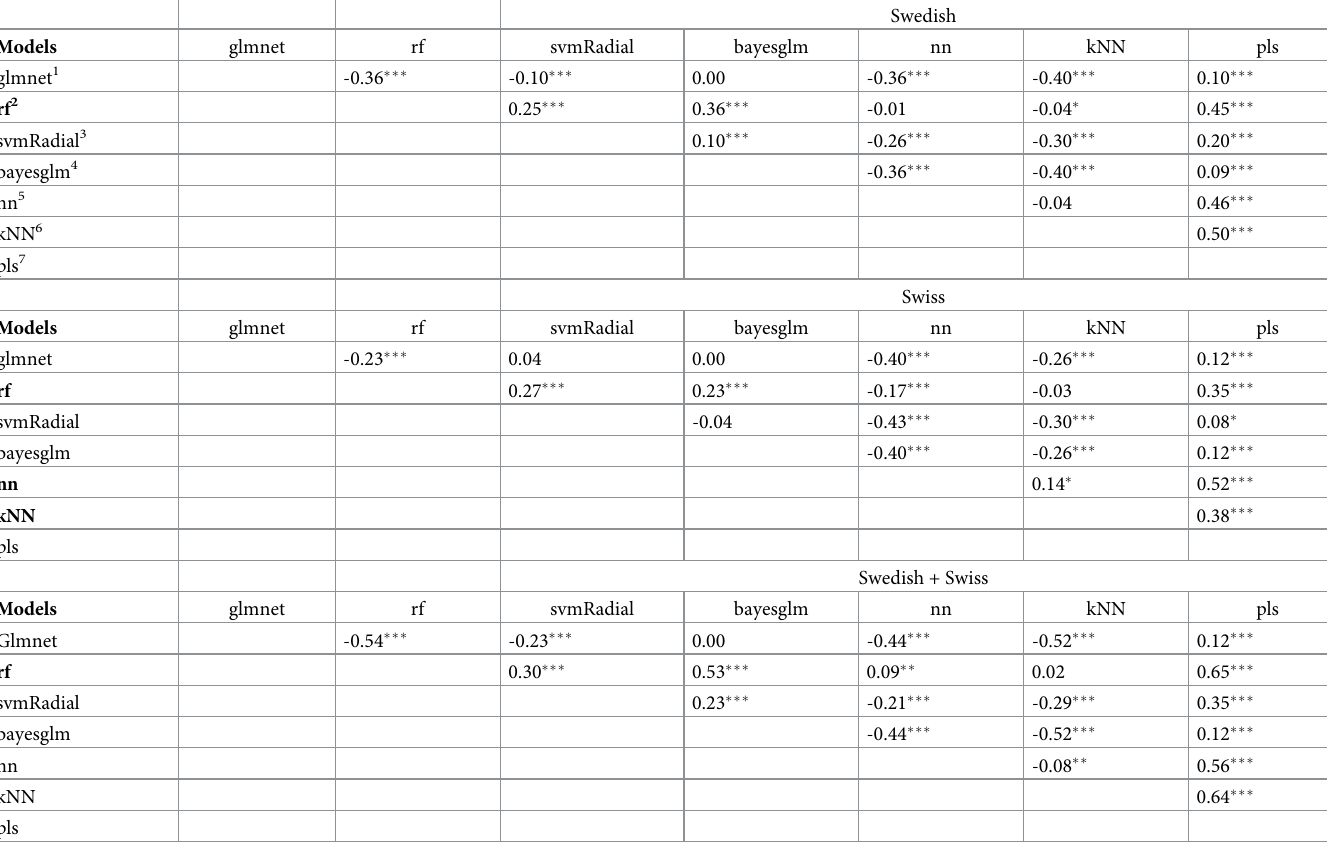
Table 9. Comparisons of models’ TPR performances when predicting unseen pens [leave one out cross-validation (LOOP) approach] of the Swedish, Swiss and Swedish+Swiss data sets. Estimated differences in TPR between the model indicated in the line header and the model indicated in the column header. Models in bold are considered as the best predictive models regarding their TPR.